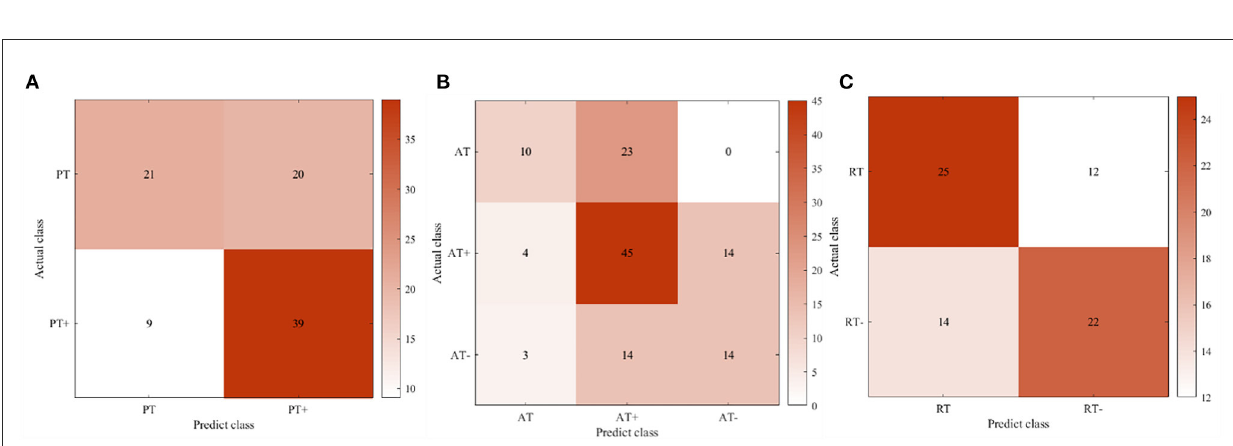
FIGURE7 The confusion matrix of participant four in the online experiment. (A) Passive training. (B) Active training. (C) Resistive